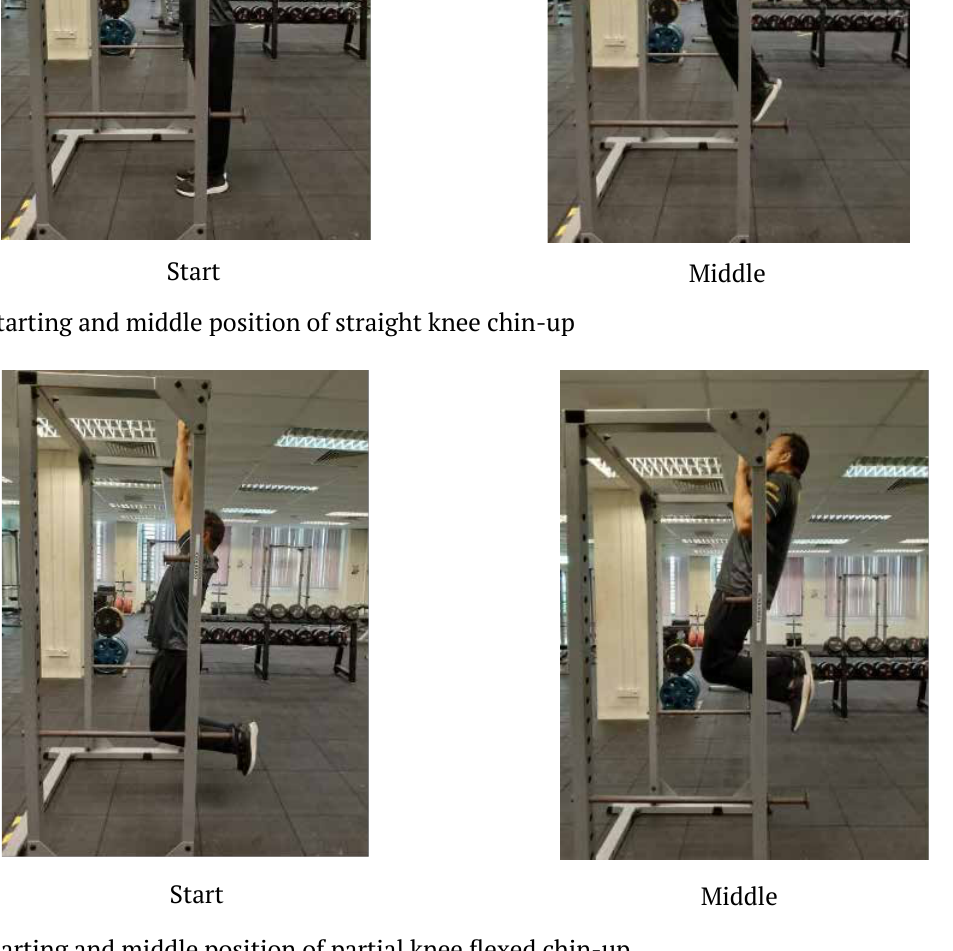
Figure 2. Starting and middle position of partial knee flexed chin-up Table 1. Physical characteristics of